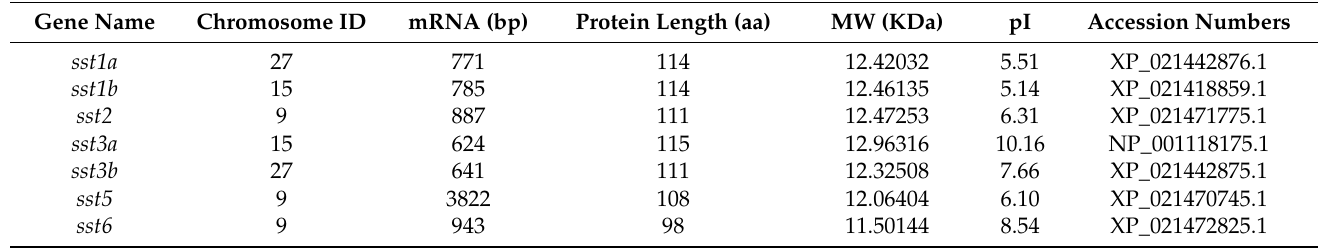
Table 1. The sequence information and accession number of sst family members.